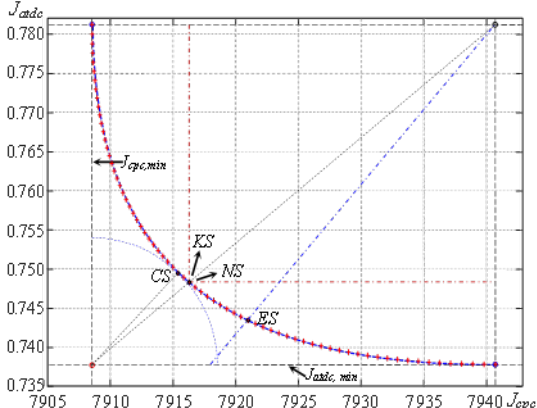
Figure 6. Decision-making based on bargaining games for the NBI Pareto front. © [2020] IEEE. Reprinted, with permission, from [10].